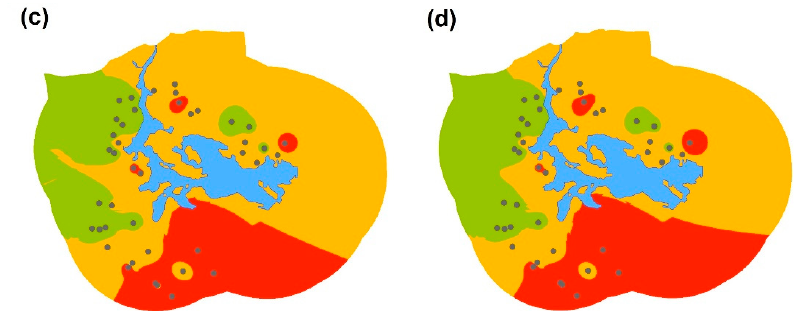
Figure 3. Distribution of drinking water suitability classes [28] based on electrical conductivity during the dry season: ( a ) March, ( b ) April, ( c ) May and ( d ) June.